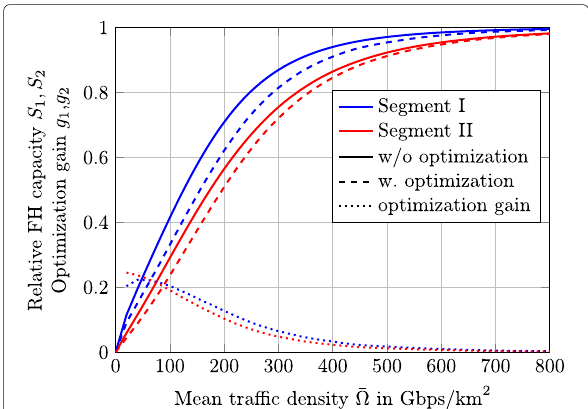
Fig. 12 Impact of pilot optimization. Relative FH capacity after optimization for K ( 0 ) max = 64 and β =